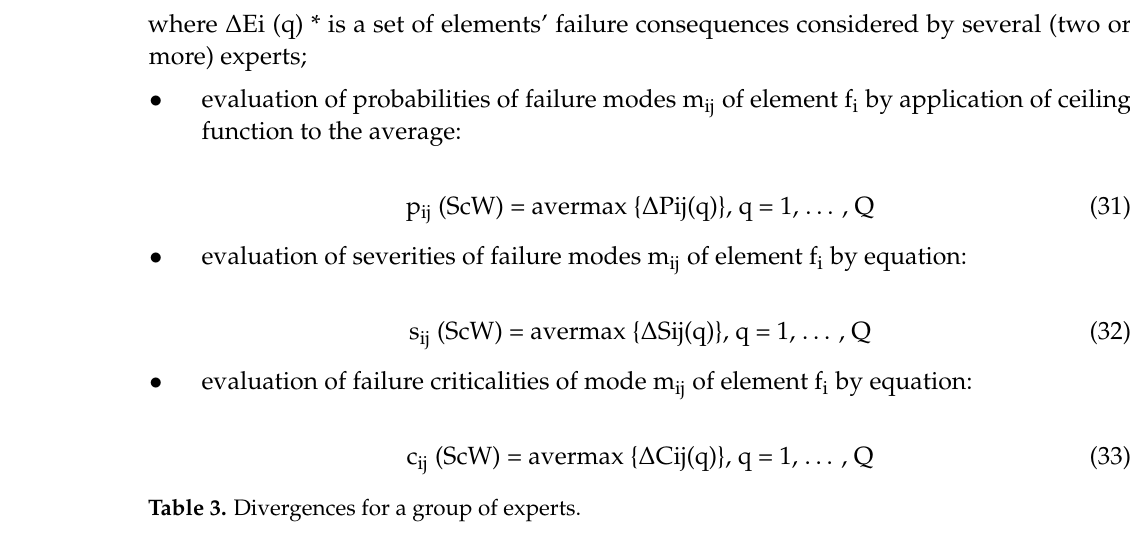
Figure 2. Relation between failure cause, modes, and effects.